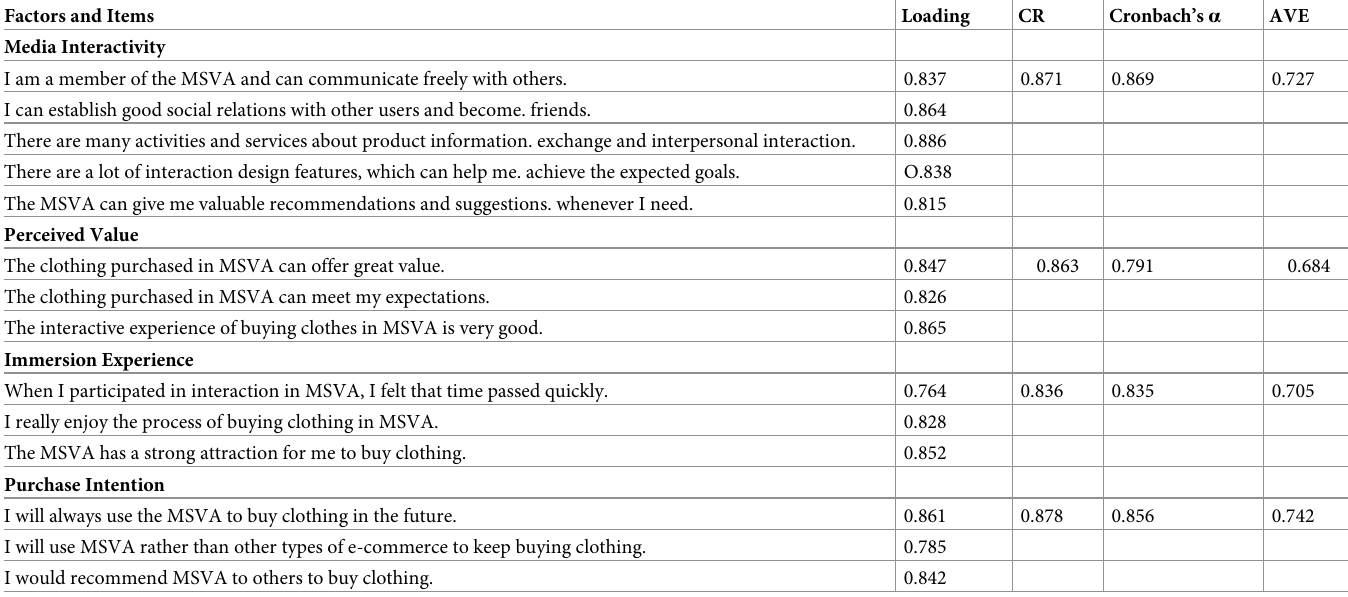
Table 3. Means, standard deviations (SD) and